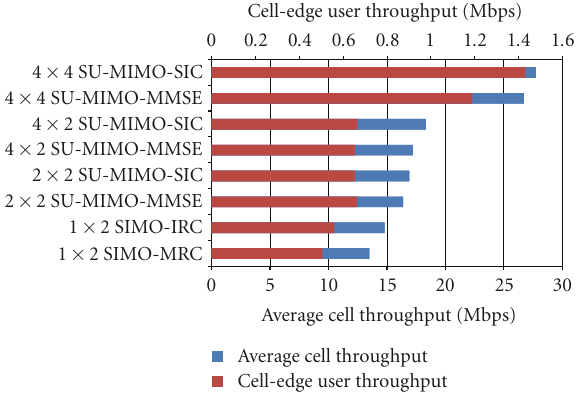
Figure 8: LTE downlink SU-MIMO